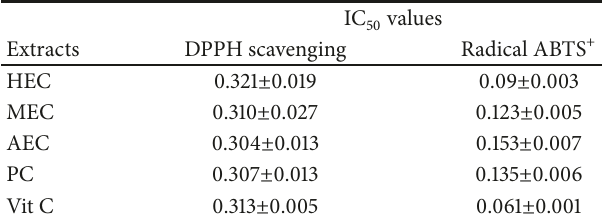
Figure 3: Calibration curve of rutin in determination of flavonoid content of C. edulis . Table 2: IC 50 values of C. edulis extracts and vitamin C in DPPH scavenging, ABTS activity, and reducing power assays.